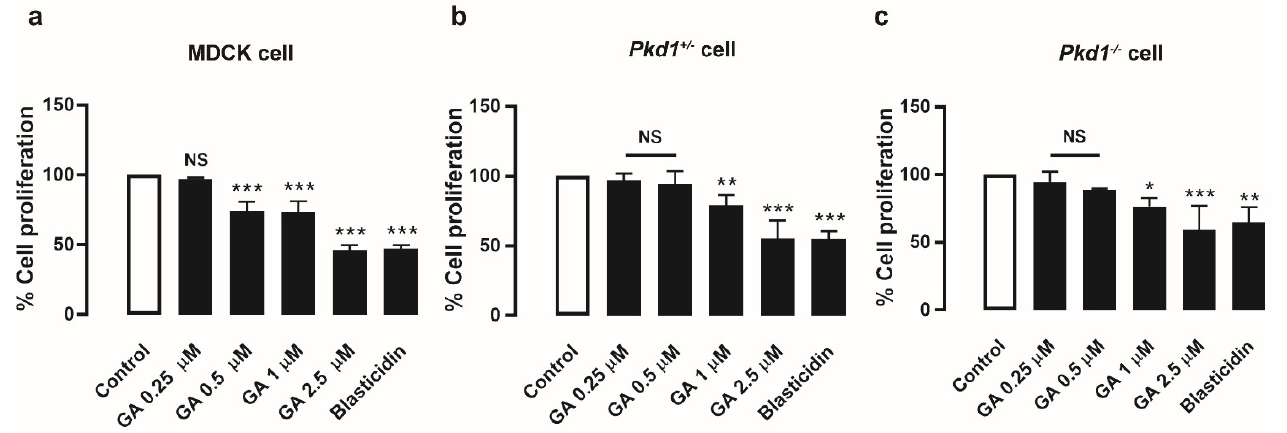
Figure 2. Effect of gambogic acid on cell proliferation. MDCK and Pkd1 mutant cell proliferation was measured by BrdU incorporation. The graphs show the percentage of cell proliferation in MDCK cells ( a ) Pkd1 + / − cells ( b ) Pkd1 − / − cells ( c ) after incubation with DMSO (control), GA at doses of 0.25, 0.5, 1, and 2.5 μM, and 20 μg/mL of blasticidin for 24 h (mean of % control ± SEM, n = 4, * p < 0.05, ** p < 0.01, *** p < 0.001, NS; not significant).